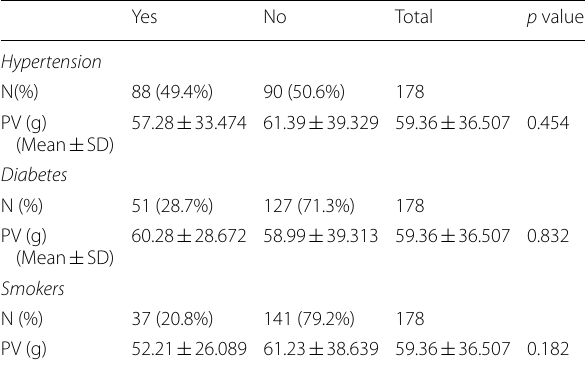
Table 3 Relationship between PV and hypertension, diabetes